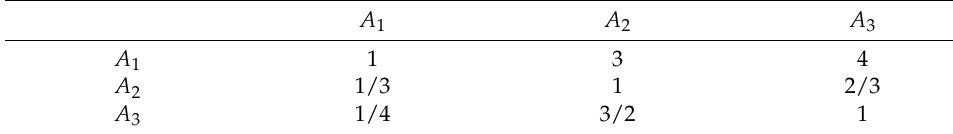
Table 3. The importance of the three basic data of static obstacle avoidance. A